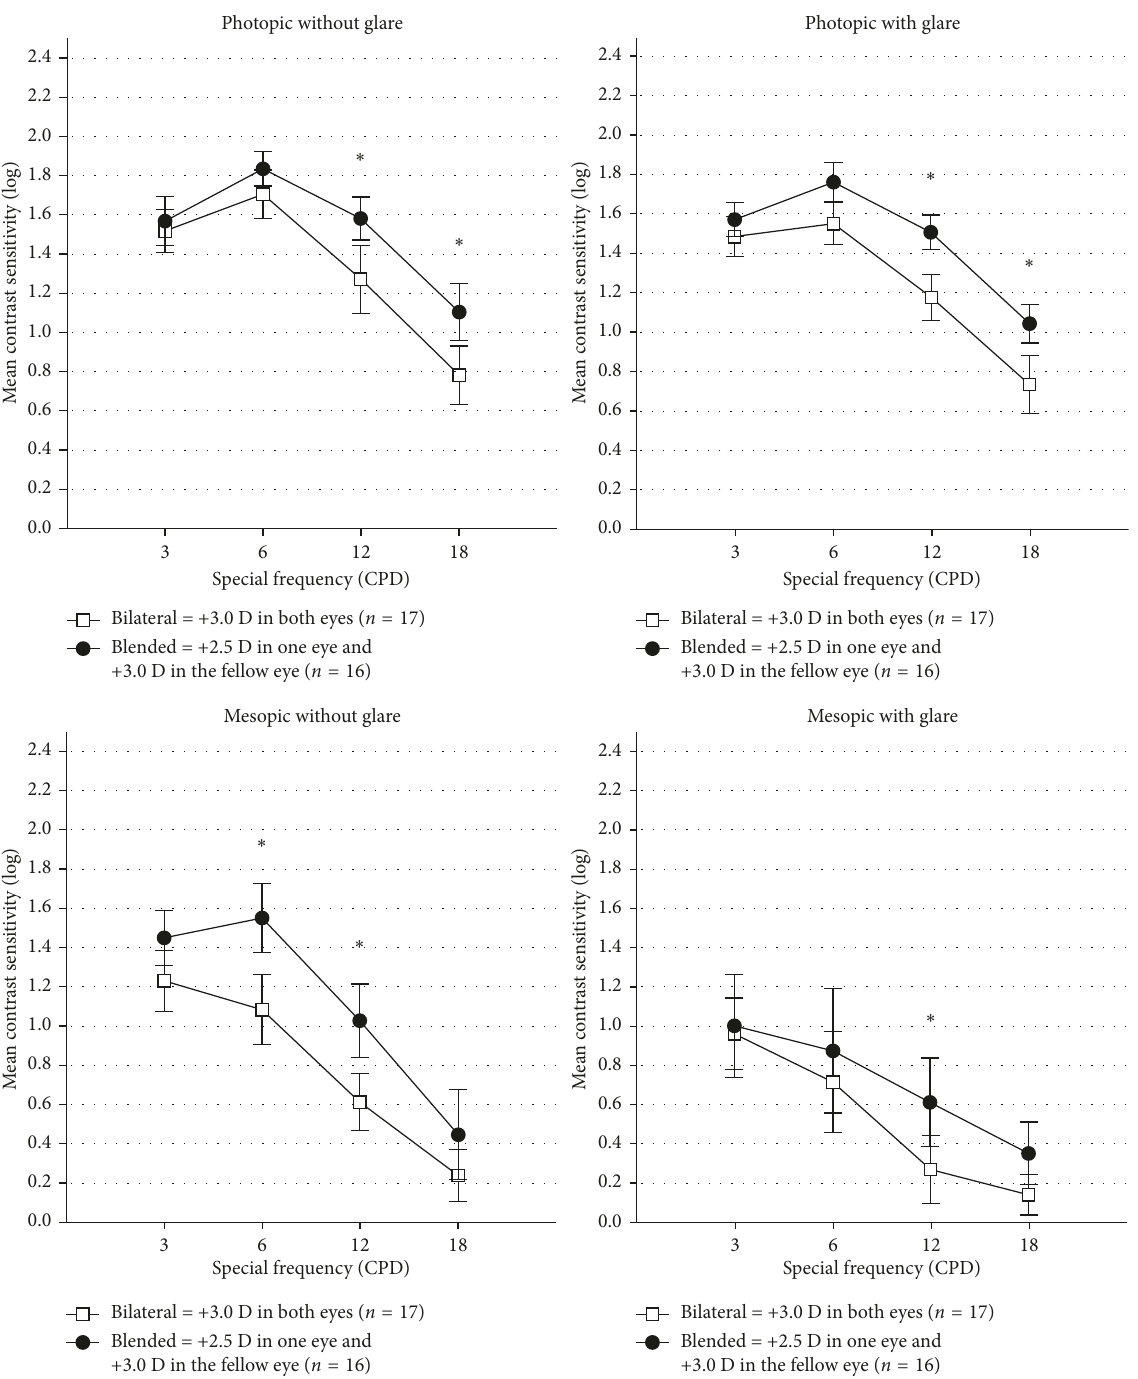
Figure 2: Mean and 95% confidence limits for binocular contrast sensitivity testing under photopic and mesopic conditions with or without glare. CPD, cycles per